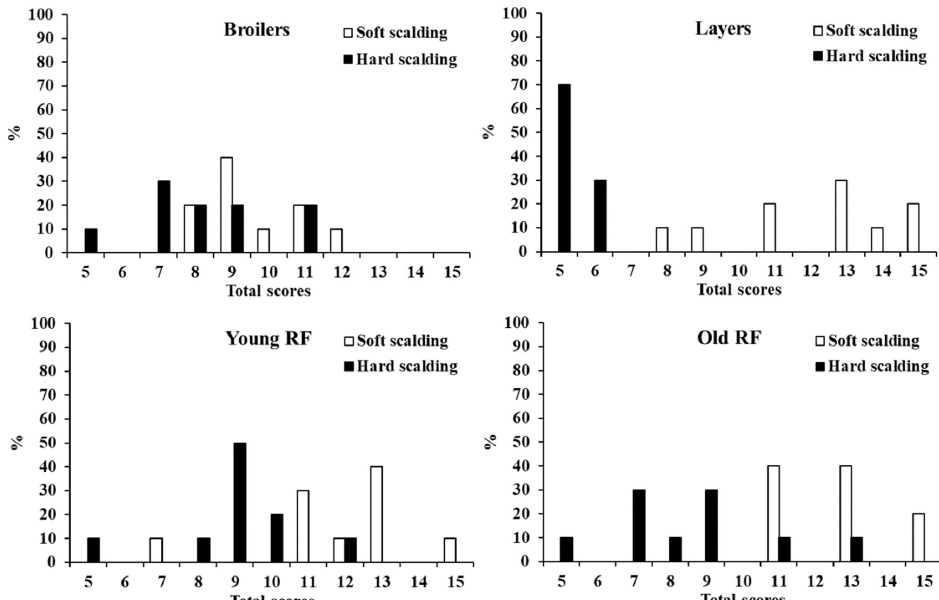
Figure 1. The distribution of total defeathering score of different breeds of chickens. After soft (57 °C/120 s) or hard (60 °C/60 s) scalding, carcasses were automatically plucked for 60 s in the tank. Five major parts of the carcass including neck, body, wings, legs, and tail were evaluated for defeathering effects based on the 3-level system. The scores of each part of individual bird were combined to produce a total with a range from a minimal score 5 to 15 for maximum. Results were expressed as a percentage of total birds of each breed in the 5–15 scale (n = 20).